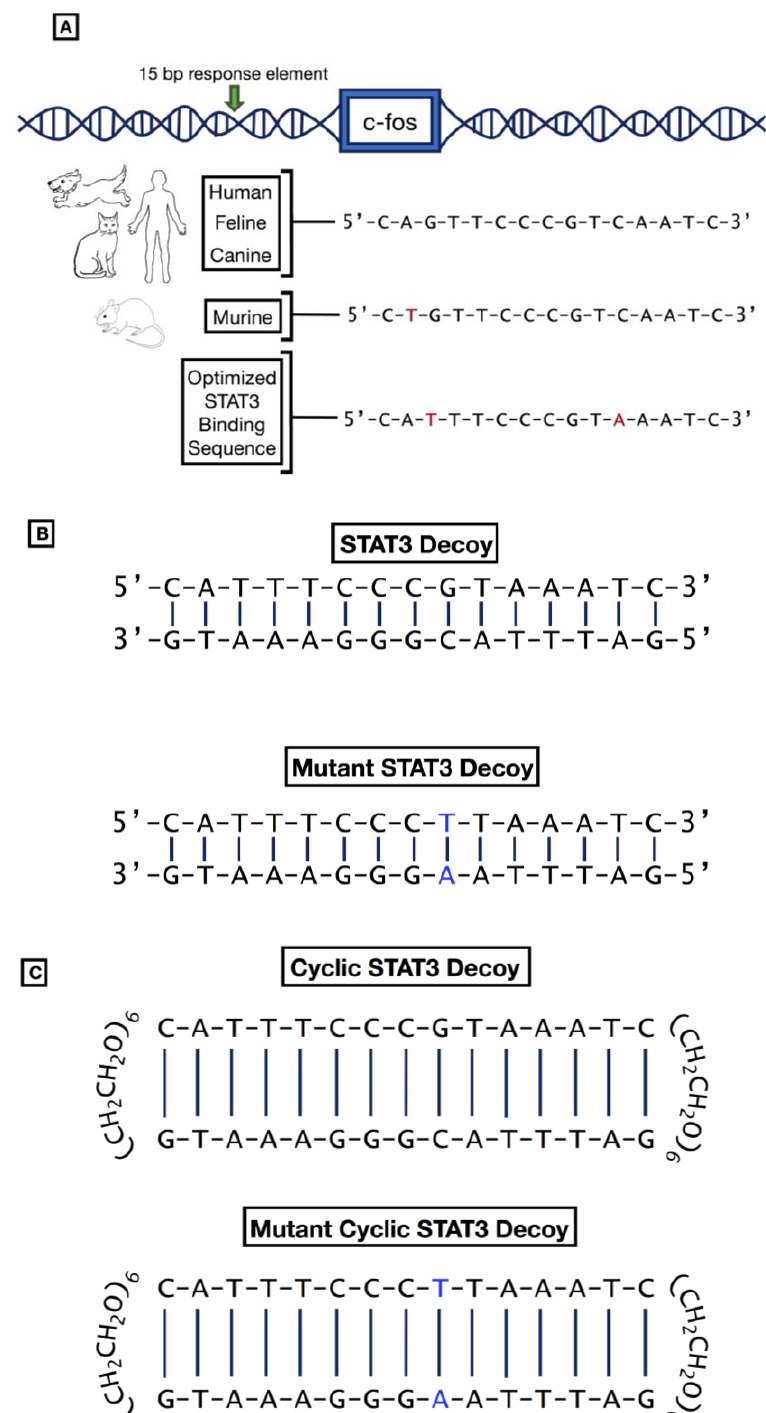
Figure 3. STAT3 response elements and STAT3 decoys. ( A ) The human serum-inducible element (hSIE) sequence is located upstream in the promoter region of the human c-fos gene and is almost perfectly conserved across human, feline, canine, and murine species. Sequence di ff erences are shown in red. Below these is an optimized STAT3 binding sequence, with sequence modifications, shown in red, at positions 3 and 11 [52]. This allows the decoy to act as a direct competitive inhibitor of the DNA binding domain in the STAT3 molecule and thus inhibit expression of downstream anti-apoptotic and pro-proliferative signals. ( B ) Structure of the first-generation linear STAT3 decoy and mutant STAT3 decoy which is administered intratumorally in in vivo models. The location of the mutation in the mutant decoy is shown in blue. ( C ) Structure of the cyclic STAT3 decoy and mutant cyclic STAT3 decoy, with hexaethylene glycol linkages which is administered intravenously in in vivo models. The location of the mutation in the mutant decoy is shown in